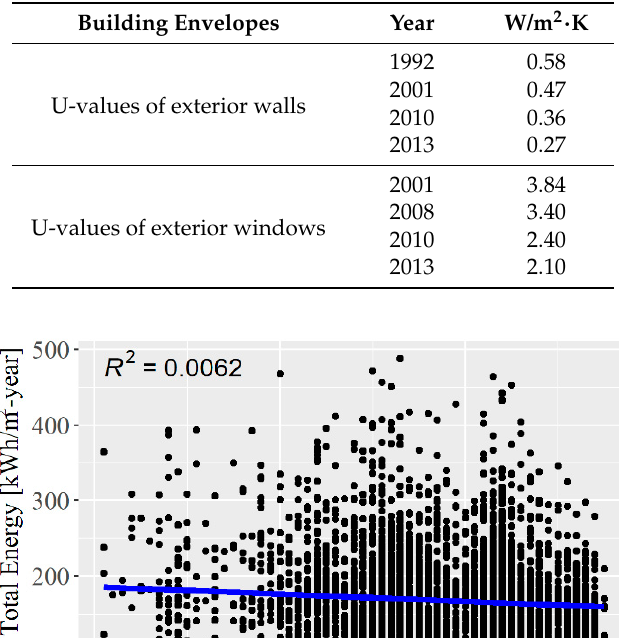
Table 2. Changes to prescriptive building energy codes with regard to non ‐ residential building envelopes (Seoul, South Korea).